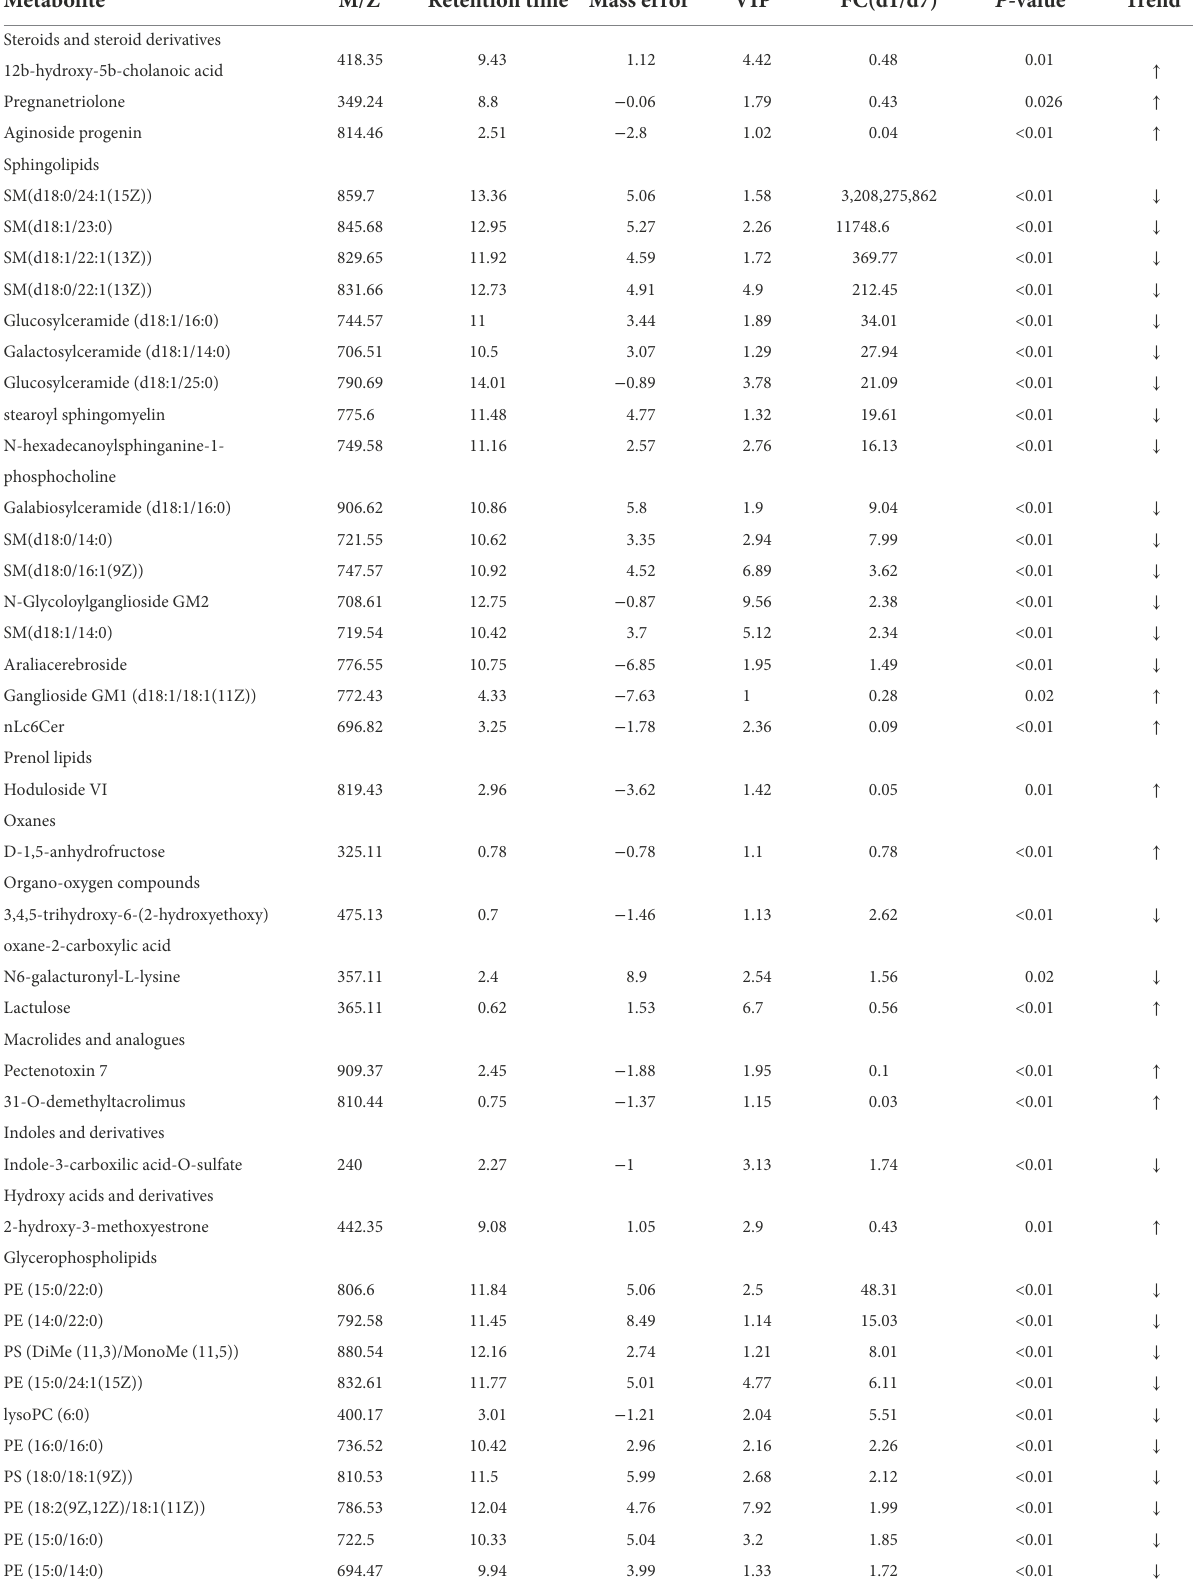
TABLE 4 Milk metabolites on day 1 compared to day 7 of MCH treatment ( n = 6). Metabolite M/Z Retention time Mass error VIP FC(d1/d7) P -value